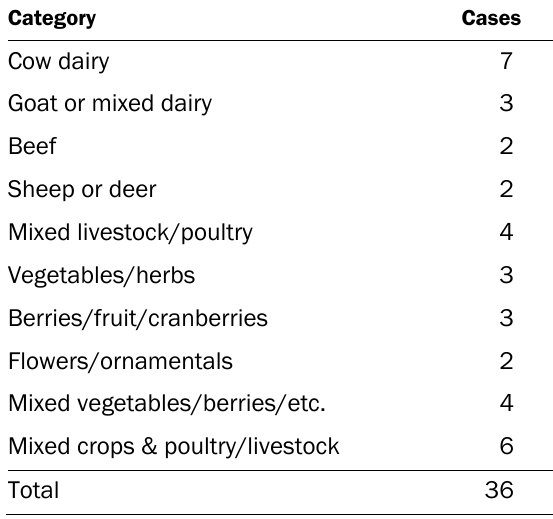
Table 5. Main Market Type for